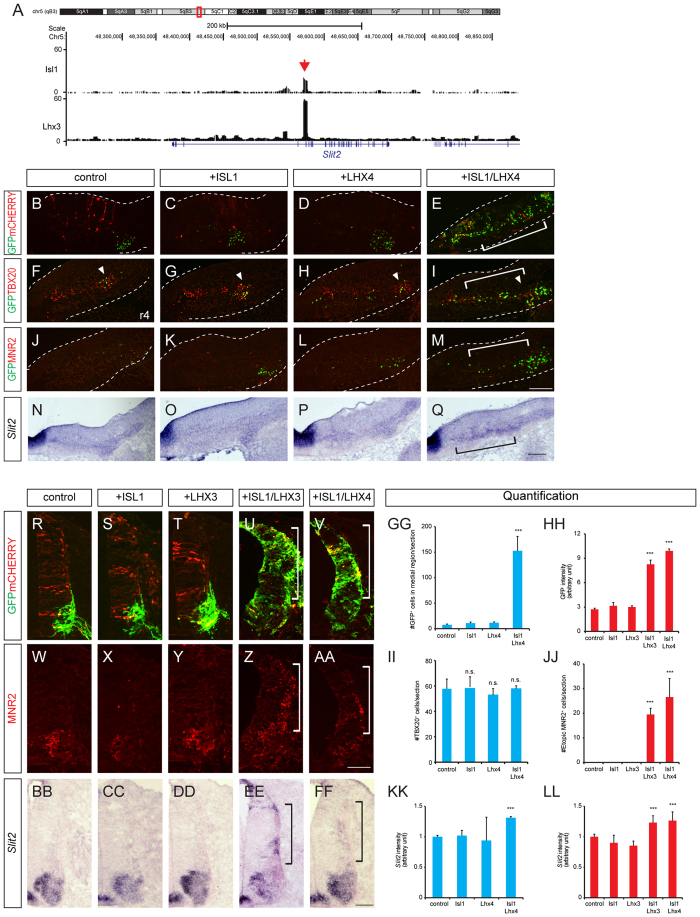
ISL1-LHX3/4 complexes activate the Slit2 enhancer.(A) ChIP-seq analysis of ISL1 and LHX3 binding to the Slit2 genome. Red arrow indicates Slit2 enhancer. (B–Q) GFP expression in transverse sections of HH stage 24 chick embryos electroporated with the Slit2 enhancer: GFP reporter, the CMV::mCherry vector as an internal control, ISL1, or LHX4 as indicated. Expression of Slit2, TBX20 and MNR2 was assessed in adjacent sections. In the hindbrain, the GFP signal is present in BM neurons (arrowheads), which have become medially expanded in the presence of ISL1 and LHX4 (brackets). Slit2 mRNA is induced in the same area (bracket), while the number of TBX20-expressing cells is unchanged. (R-FF) In the spinal cord, GFP activity is present in SM neurons. In the presence of ISL1-LHX3 or ISL1-LHX4, however, GFP expression and Slit2 mRNA have expanded dorsally together with ectopic MNR2-expressing cells (brackets) (>3 sections in 3 embryos in each group). (GG–LL) Quantification of GFP and Slit2 intensities, and TBX20 and MNR2-expressing cells (>3 sections in 3 embryos in each group). Error bars represent SEM. ***p < 0.001; Mann-Whitney rank sum test in GG (n = 4), unpaired Student’s t-test in (HH–LL) (n = 4); n.s., not significant. Scale bars: in (M), 100 μm for (B–M) in (Q), 100 μm for (N–Q) in (AA), 100 μm for (R-AA) in (FF), 100 μm for (BB–FF).